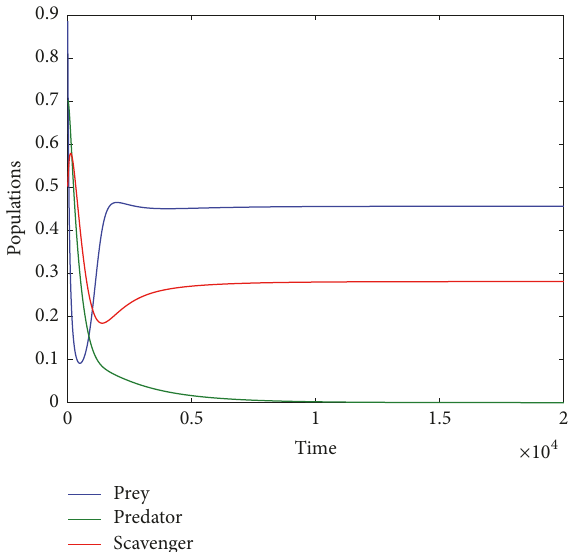
Figure 4: Time series for the solution of system (3) using data (76) with 𝛾 = 0.35 . The system approaches 𝐸 3 = (0.45,0, 0.28) .